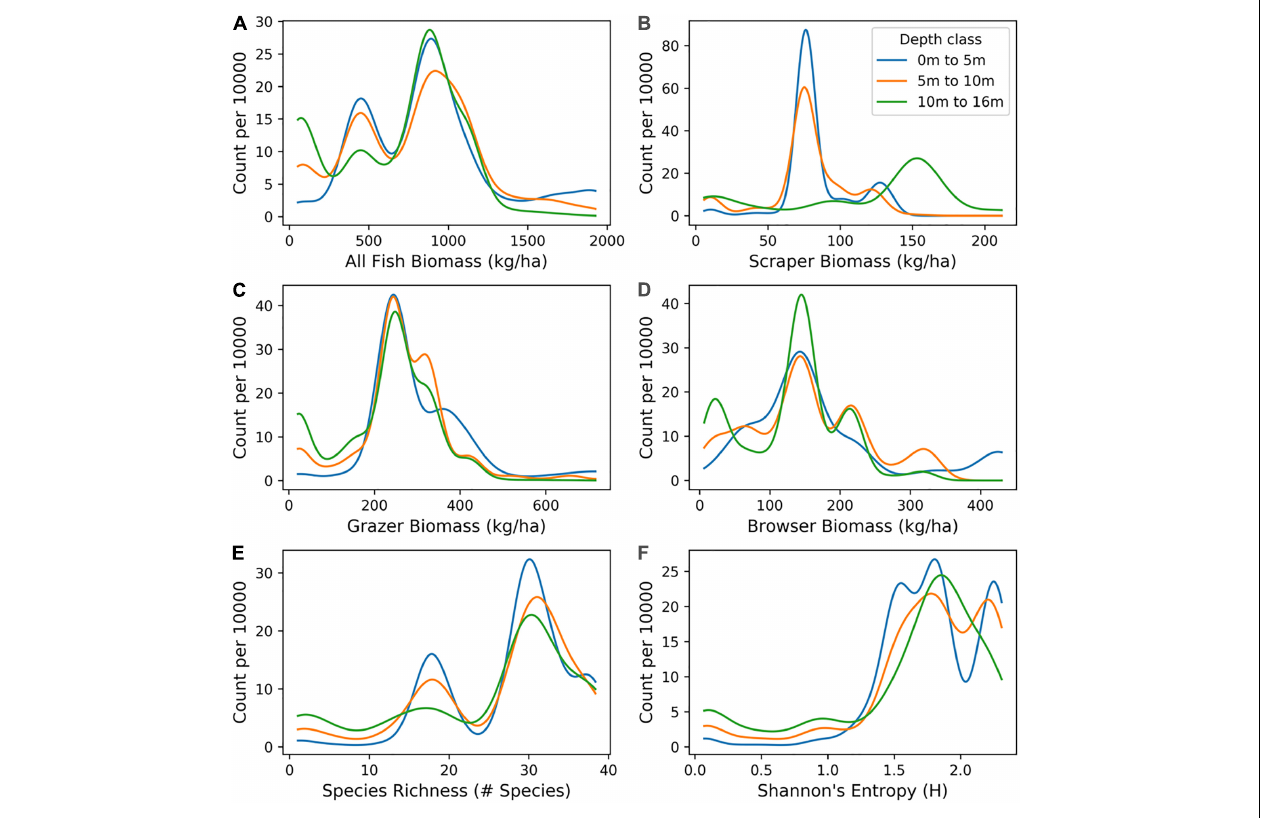
FIGURE 9 | Distribution of mapped biomass of: (A) All fish, and for fish classified as (B) scrapers, (C) browsers, and (D) grazers, as well as two measures of biodiversity: (E) species richness and (F) Shannon index, as distributed in benthic depths 0–5 m, 5–10 m, and 10–16 m across the South Kona